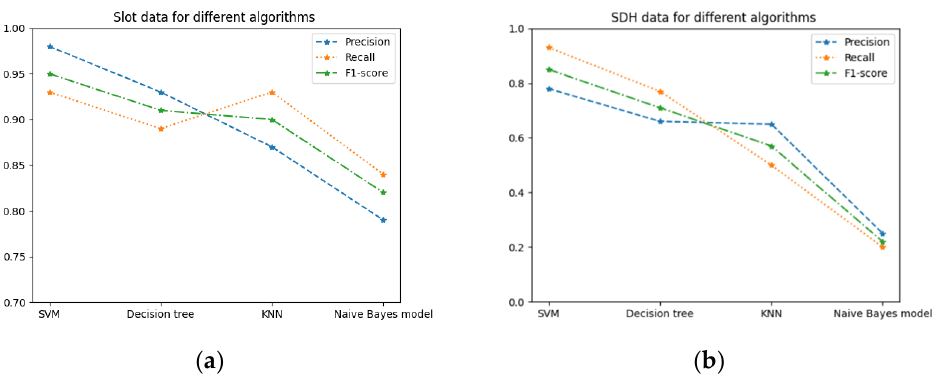
Figure 13. ( a ) Slot data for different algorithms; ( b ) SDH data for different algorithms.